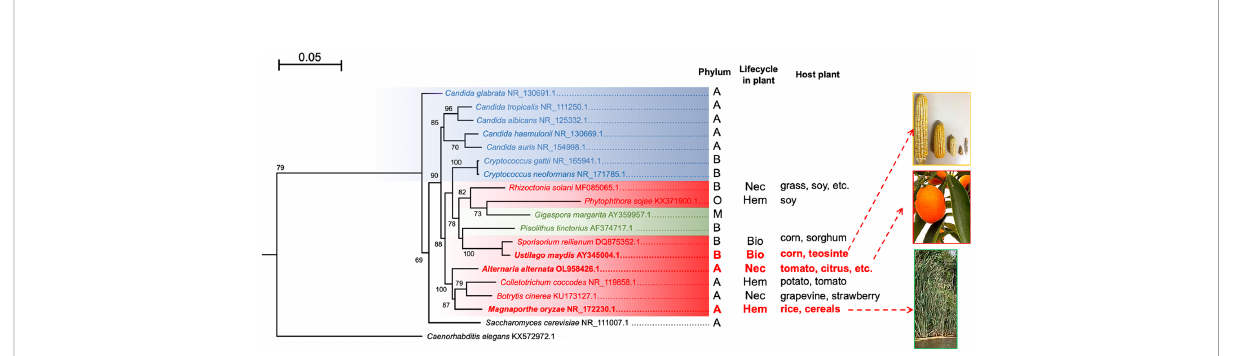
FIGURE 2 Maximum likelihood phylogenetic tree constructed with the sequences of the ITS regions of different fungi. Human pathogenic fungi are portrayed by blue branches, phytopathogenic fungi by red branches, and mycorrhizal fungi by green branches. S. cerevisiae and C. elegans are illustrated with black branches because the former is rarely isolated as a pathogen (its interest being purely biotechnological) and the latter served as an outgroup. The tree was generated with the MEGA11 program based on sequence alignment by using the MUSCLE algorithm, the substitution model HKY+G calculated by JModelTest, and 1,000 bootstrap replicates, as explained in the supplementary material. It was edited with the FigTree program. The phyla: A = Ascomycota, B = Basidiomycota, M = Mucoromycota, and O = Oomycota. The types of phytopathogen: Nec =necrotrophic, Bio = biotrophic, and Hem = hemibiotrophic. The host plant for each species is shown.